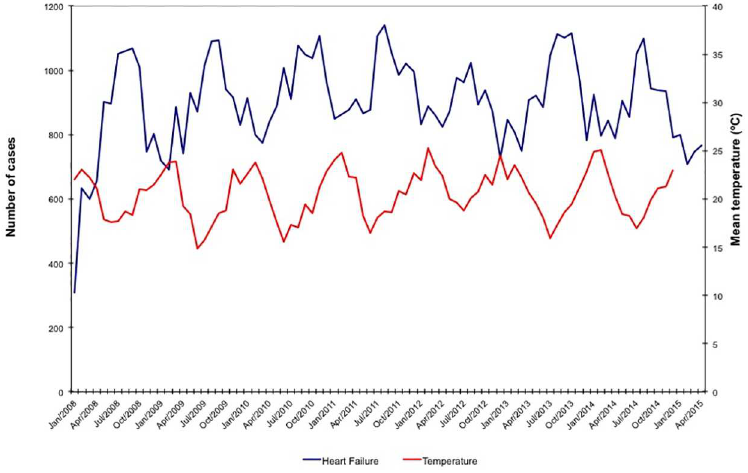
Fig 1. Monthly average temperature levels and number of hospitalizations per month for heart failure.